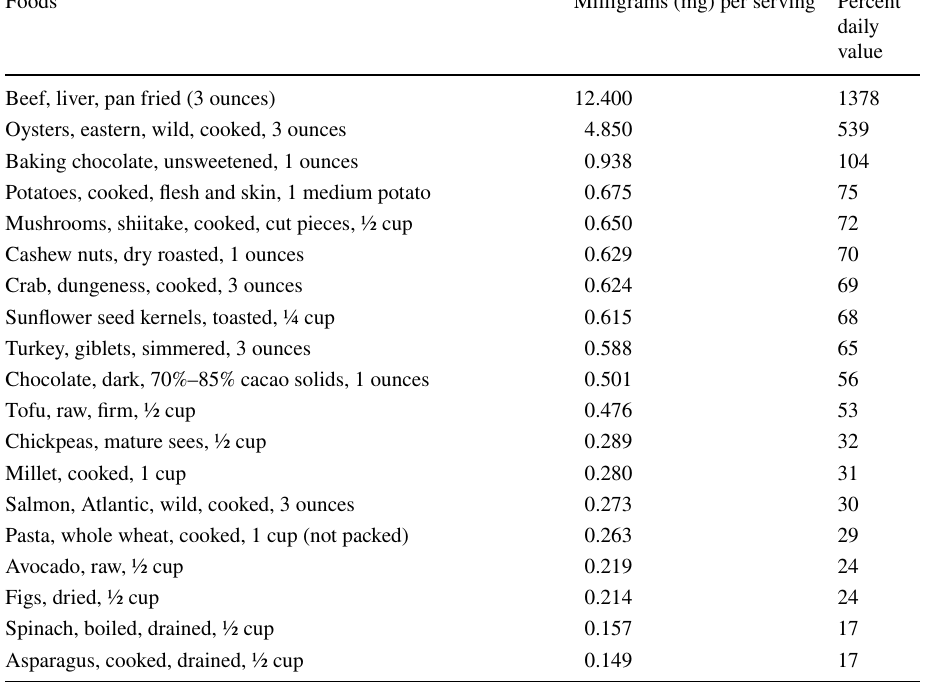
*This data was obtained from Food and Drug Administration of United States. The Food and Drug Admin- istration of United States has developed Daily Values (DVs) in order to help the public compare the nutri- ent contents of foods and dietary supplements within the context of a